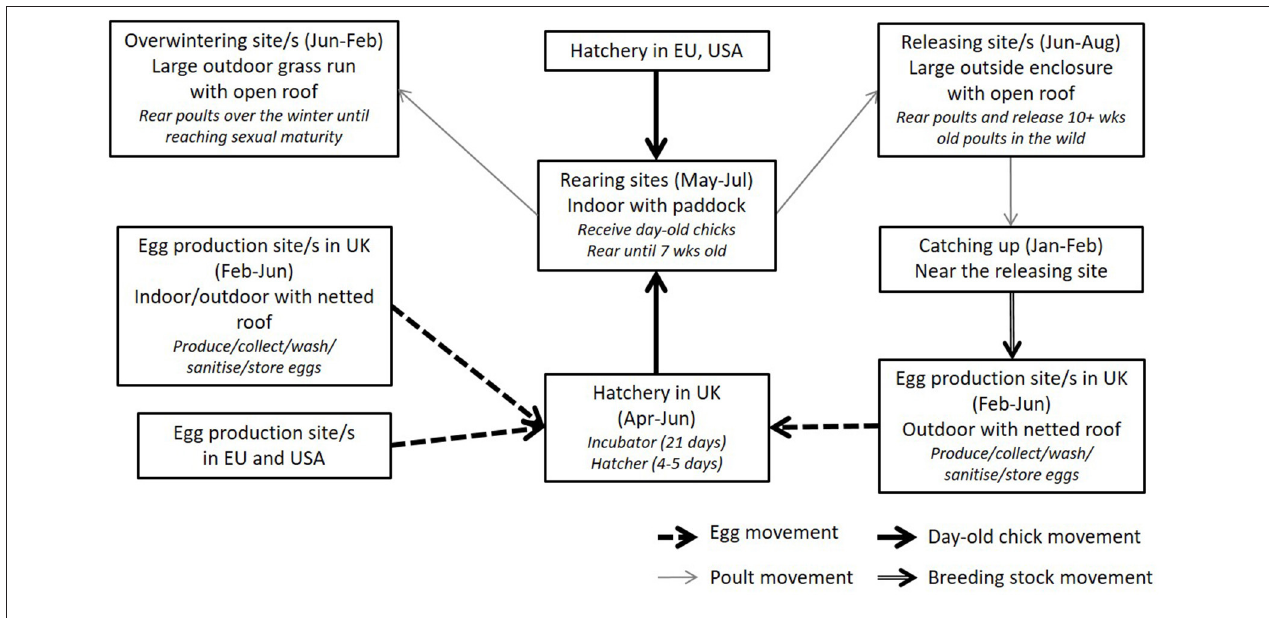
FIGURE 1 | Summary of gamebird industry structure in the United Kingdom.